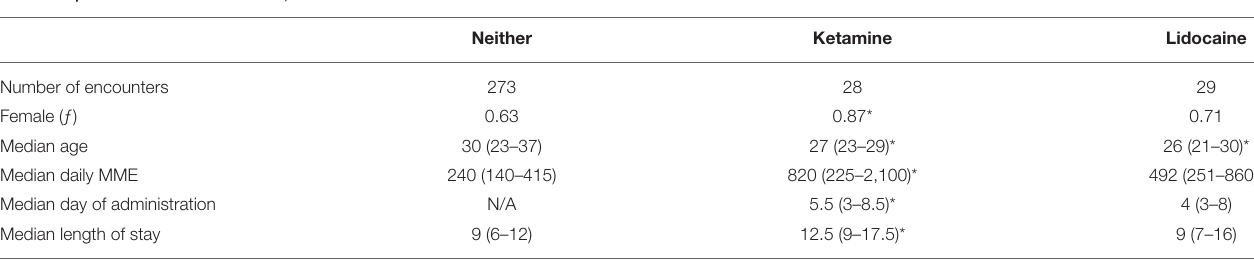
TABLE 4 | Baseline characteristics of patient